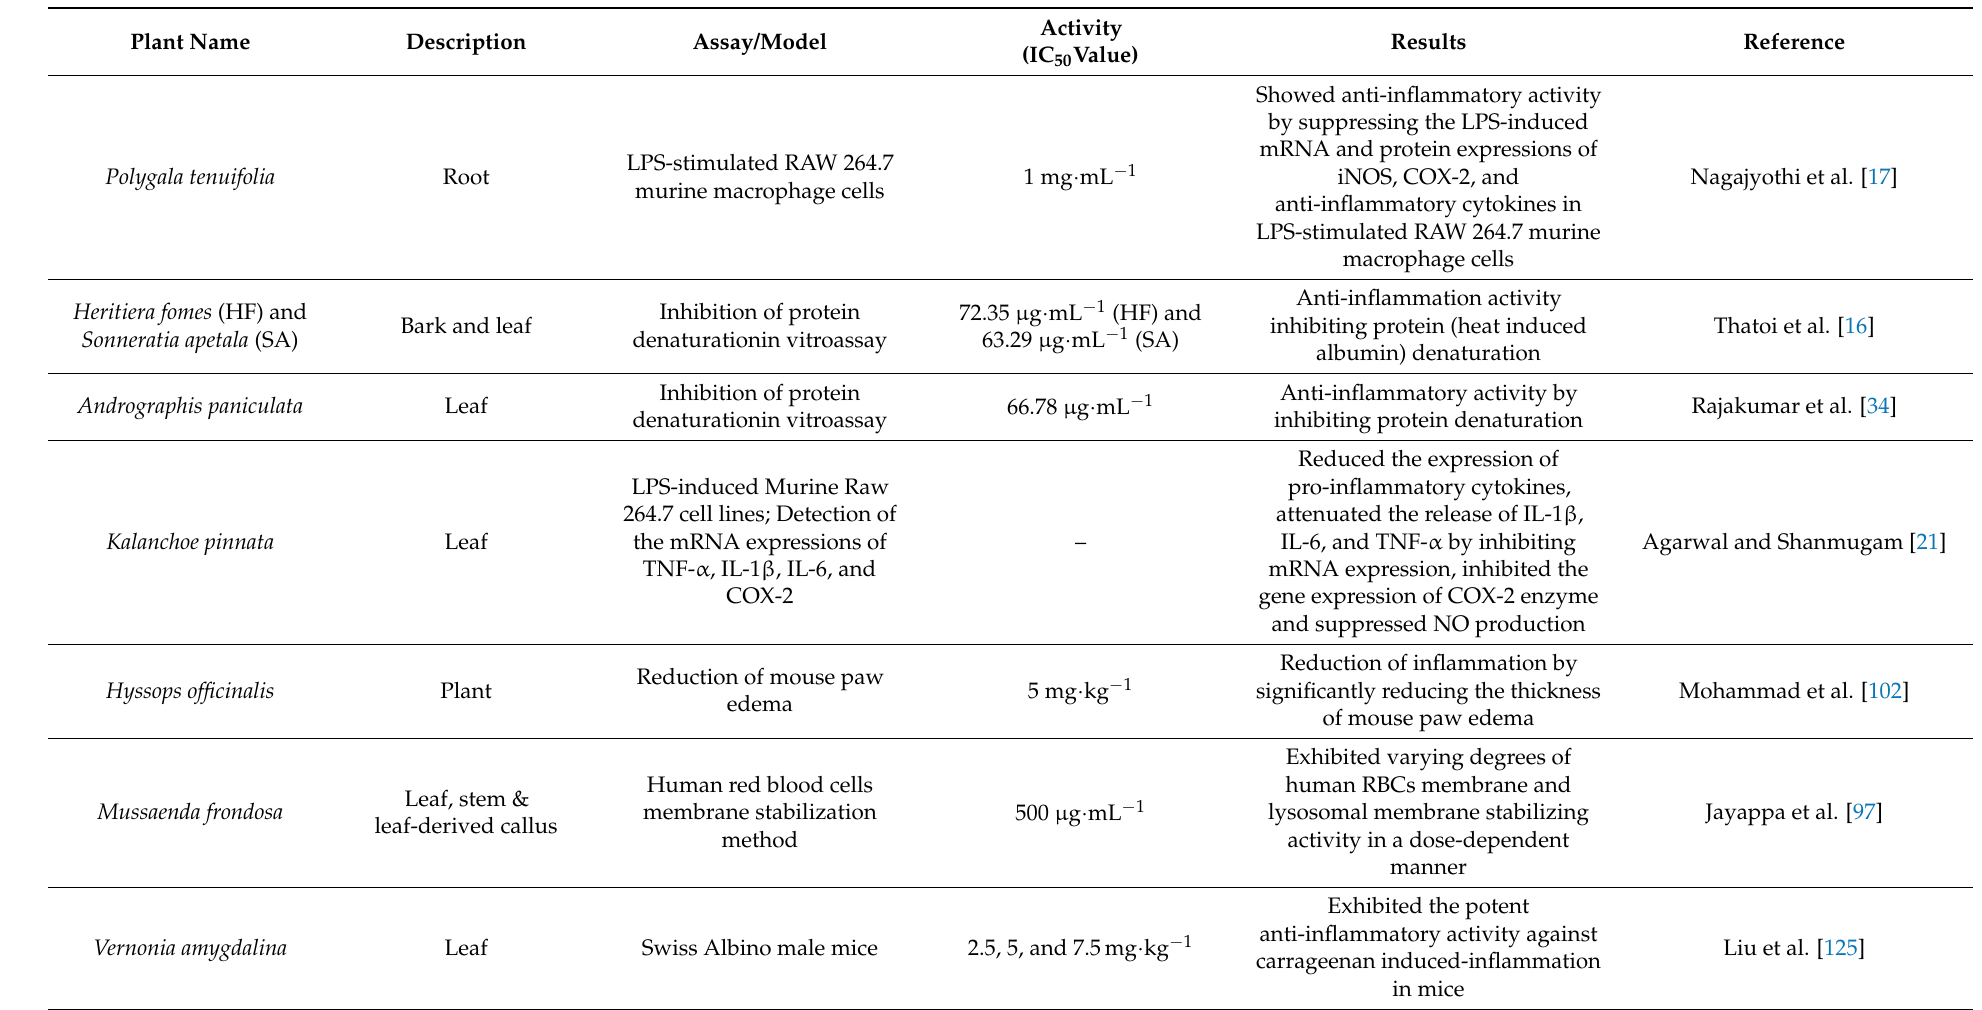
Table 6. Anti-inflammatory activity of plant-mediated green synthesized zinc oxide